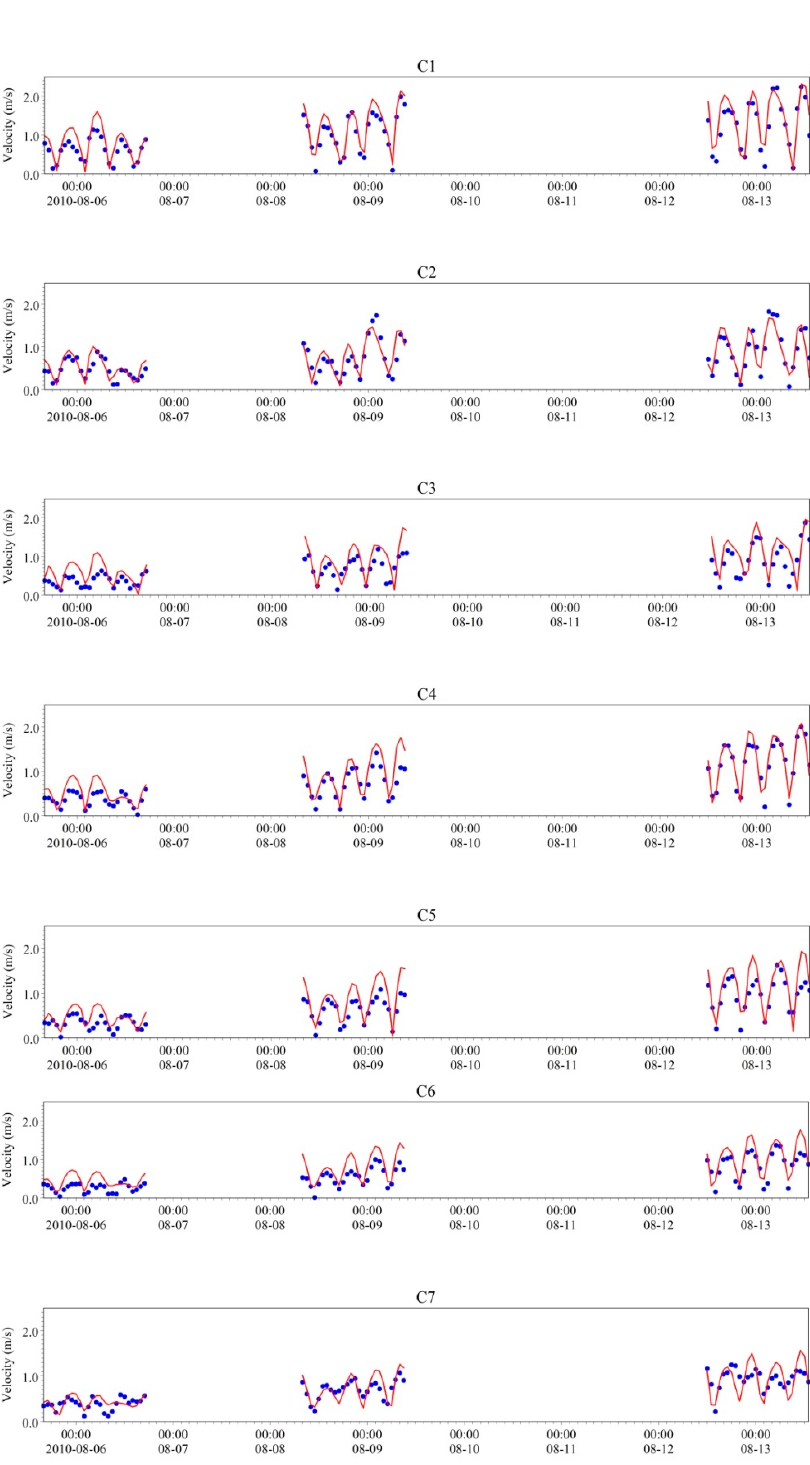
Figure 5. Tidal current velocity validation results ( signify the measured values; signify the simulated values).